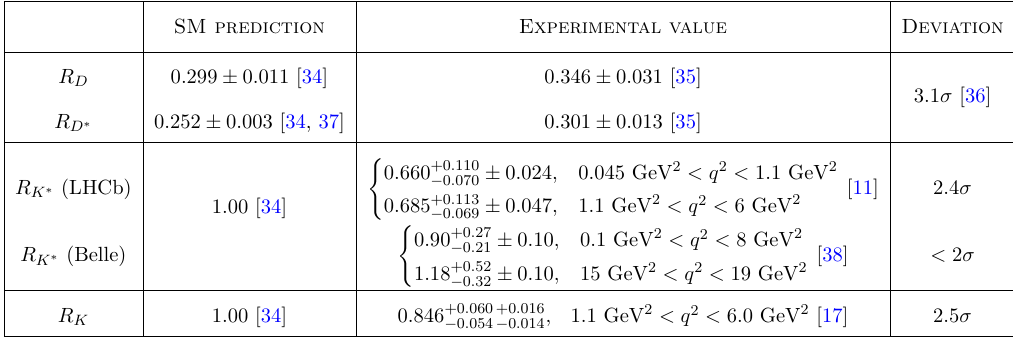
Table 2. Summary of SM predictions and global averages with statistical and systematic uncer- tainties. Global averages for R D , R D (cid:3) and R K are sourced from the Heavy (cid:13)avour Averaging Group (HFLAV) [35], and the LHCb measurement of R K (cid:3) [11]. Calculation of the averages and combined deviation from R D and R D (cid:3) will be discussed later in section